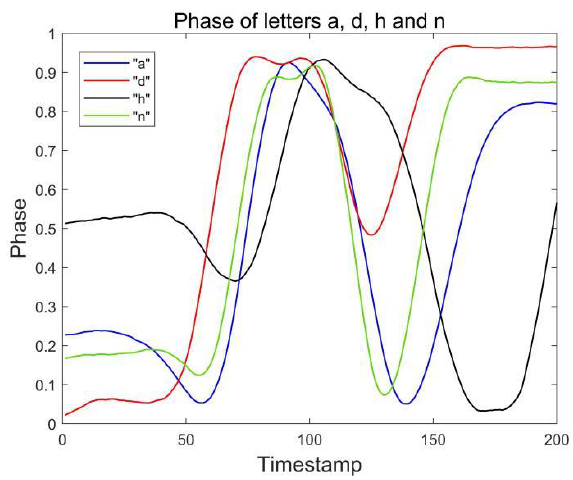
Figure 4. Phases of letters a, d, h and n collected by antenna #1.